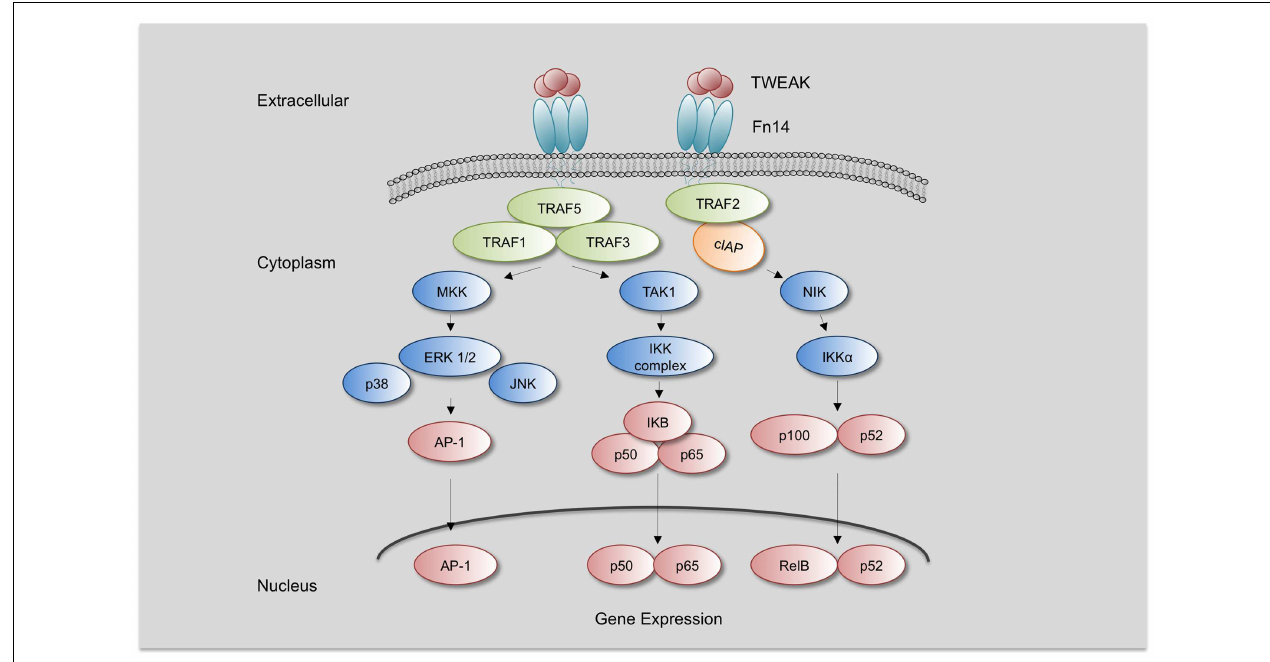
canonical or non-canonical NF- κ B pathway, respectively. MMK are responsible for the activation of c-Jun N-terminal kinase 1 (JNK1) and p38 MAPK, which activate transcription factor activator protein-1 (AP-1). Increased activation of NF- κ B and AP-1 leads to the expression of specific target genes responsible forTWEAK-mediated